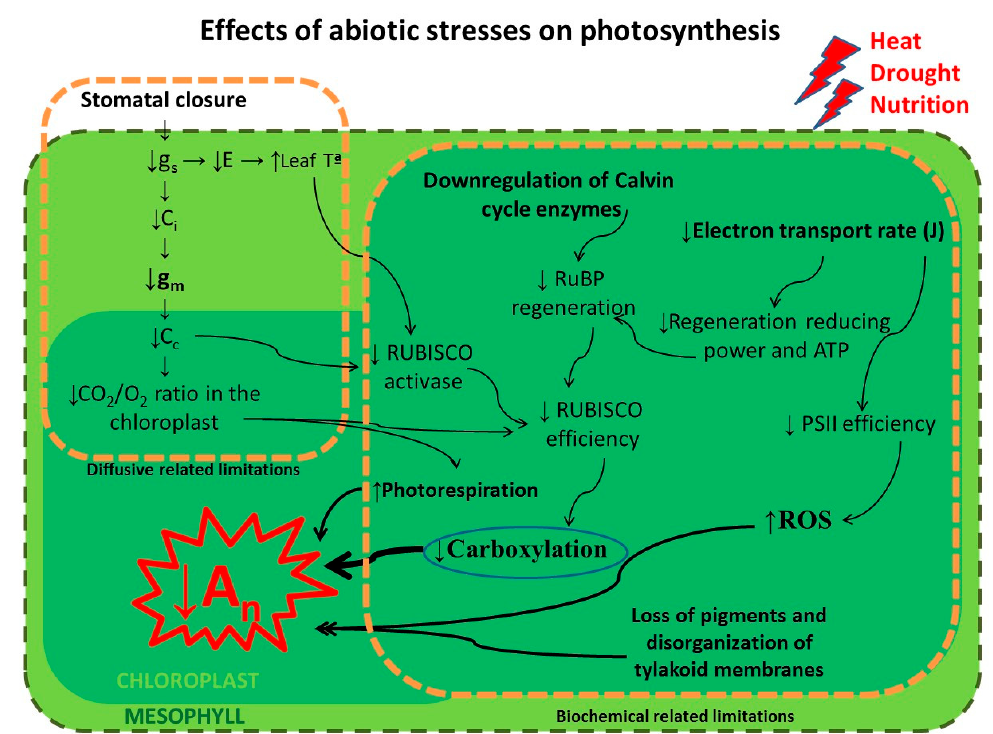
Figure 1. Photosynthetic metabolism under a changing environment. A multi-scale model representing the impact of key stress factors (high temperature, drought, and low soil fertilization levels) on photosynthetic performance associated with limitations to CO 2 di ff usion factors and / or metabolic factors. Stomatal closure diminishes sub-stomatal and chloroplast CO 2 concentration (Ci and Cc, respectively) with a consequent reduction in photosynthetic rates (An). Under severe stress conditions, limitations to the activity of Calvin cycle enzymes (Rubisco, SBPase, etc.) and the photosynthetic electron transport rate (J), and the appearance of reactive oxygen species (ROS), among others, are observed.